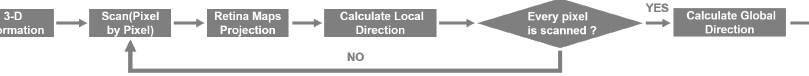
Figure 8. Algorithm